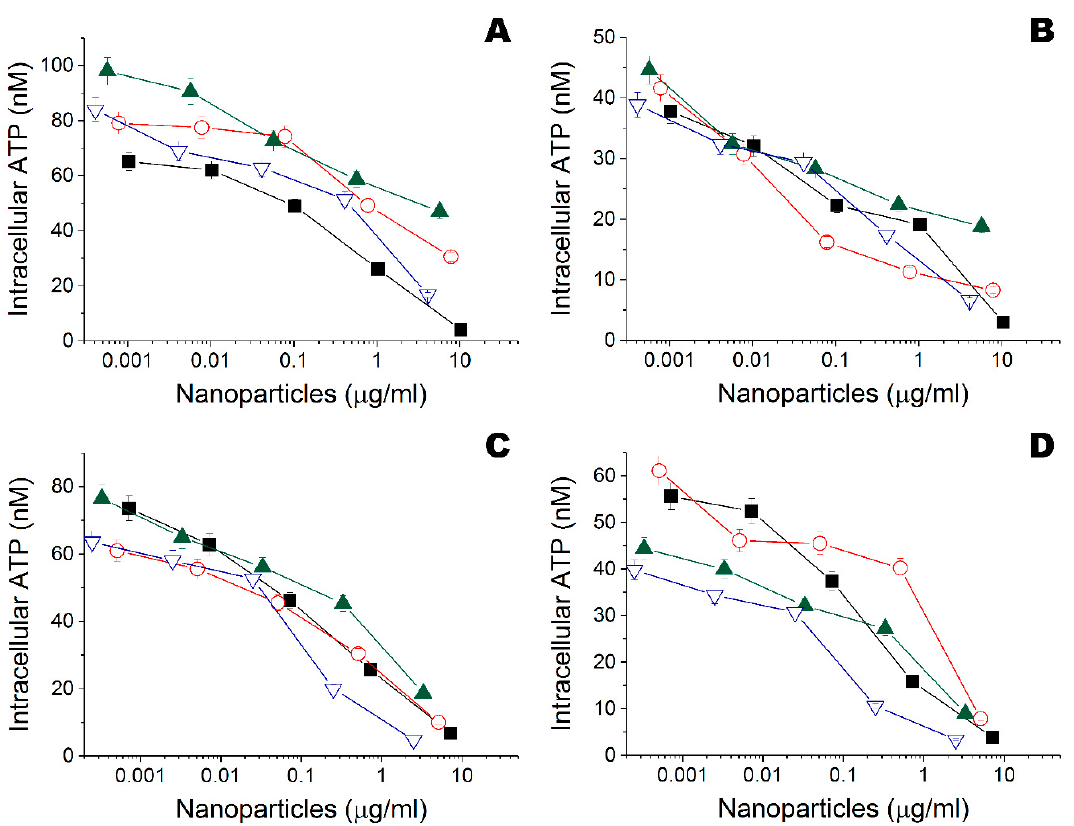
Figure 3. ( A ) Residual intensity of bioluminescence of immobilized cells Photobacterium phosphoreum treated by the Fe ( ), Ta ( ), Ti ( ▲ ), and Zn ( ) nanoparticles obtained in ethanol. ( B ) Residual intensity of bioluminescence of immobilized cells P. phosphoreum treated by the Fe ( ), Ta ( ), Ti ( ▲ ), and Zn ( ) nanoparticles obtained in water.